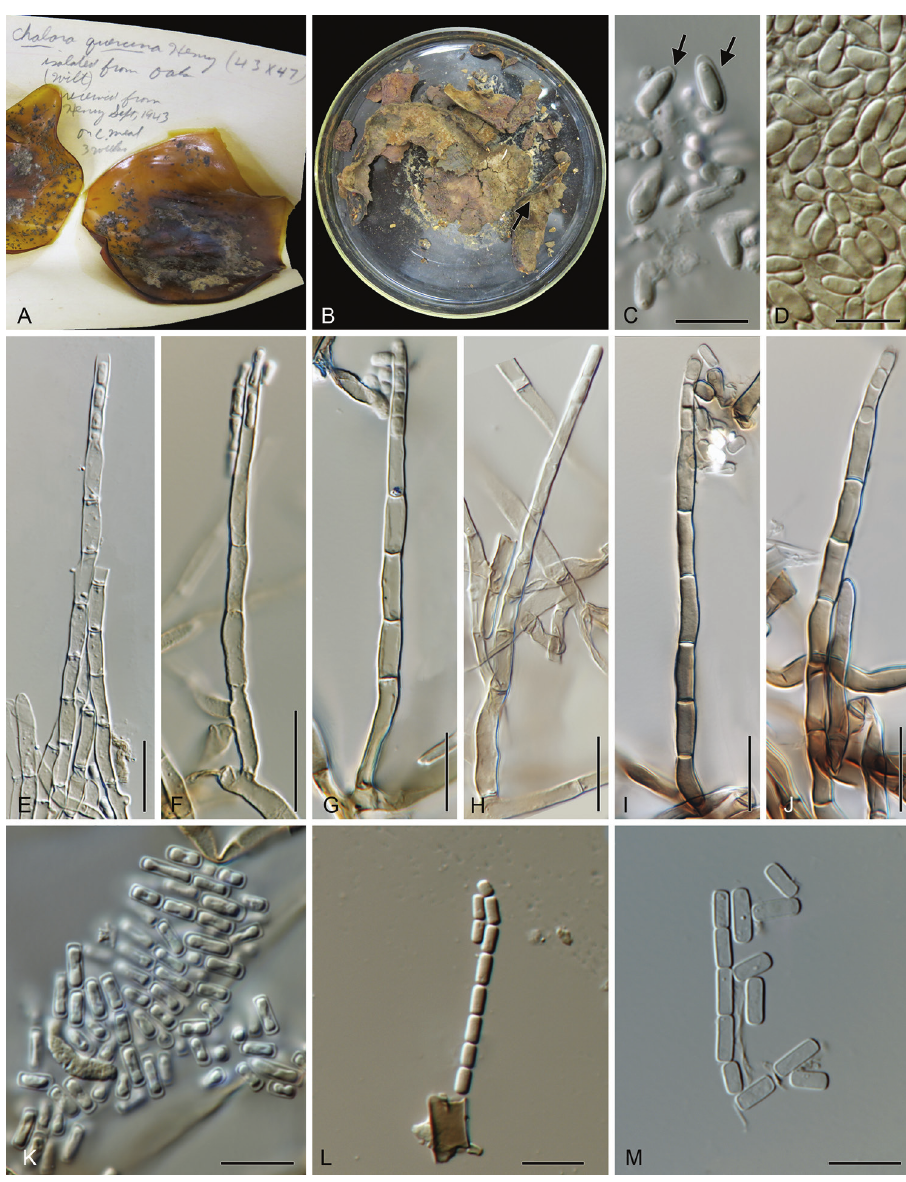
Figure 2. Morphological features of herbarium specimens and a living isolate of the oak wilt fungus. A, E, F, K Chalara quercina (BPI 595712, Lectotype) B, C, D, G, H, L Endoconidiophora fagacearum (FP 97476, Lectotype) I, J, M Living isolate treated as Ceratocystis fagacearum (CMW 2656 = CBS 138363, ex-epitype) A, B Dried cultures (arrow in B indicates the piece where ascomata were found) C, D As- cospores with sheaths (arrows) E–J Conidiophores K–M Conidia. Scale bars: C–J = 20 µm, K–M = 10